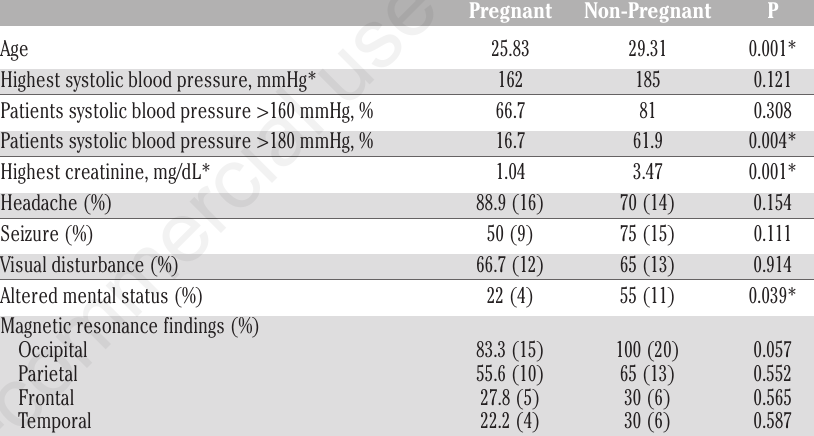
Table 1. Differences among pregnant and non-pregnant patients.